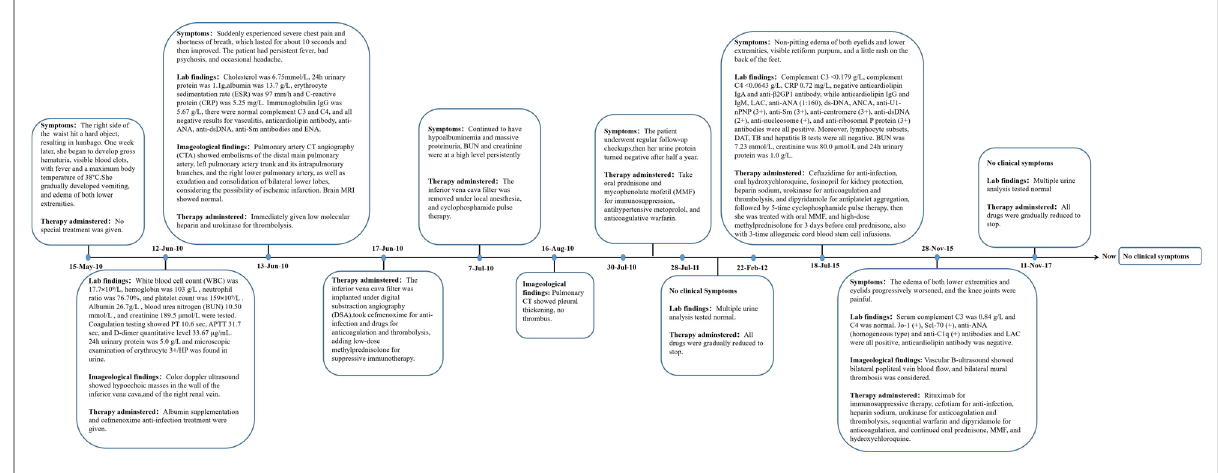
Table 1 . Albumin 26.7 g/L, blood urea nitrogen